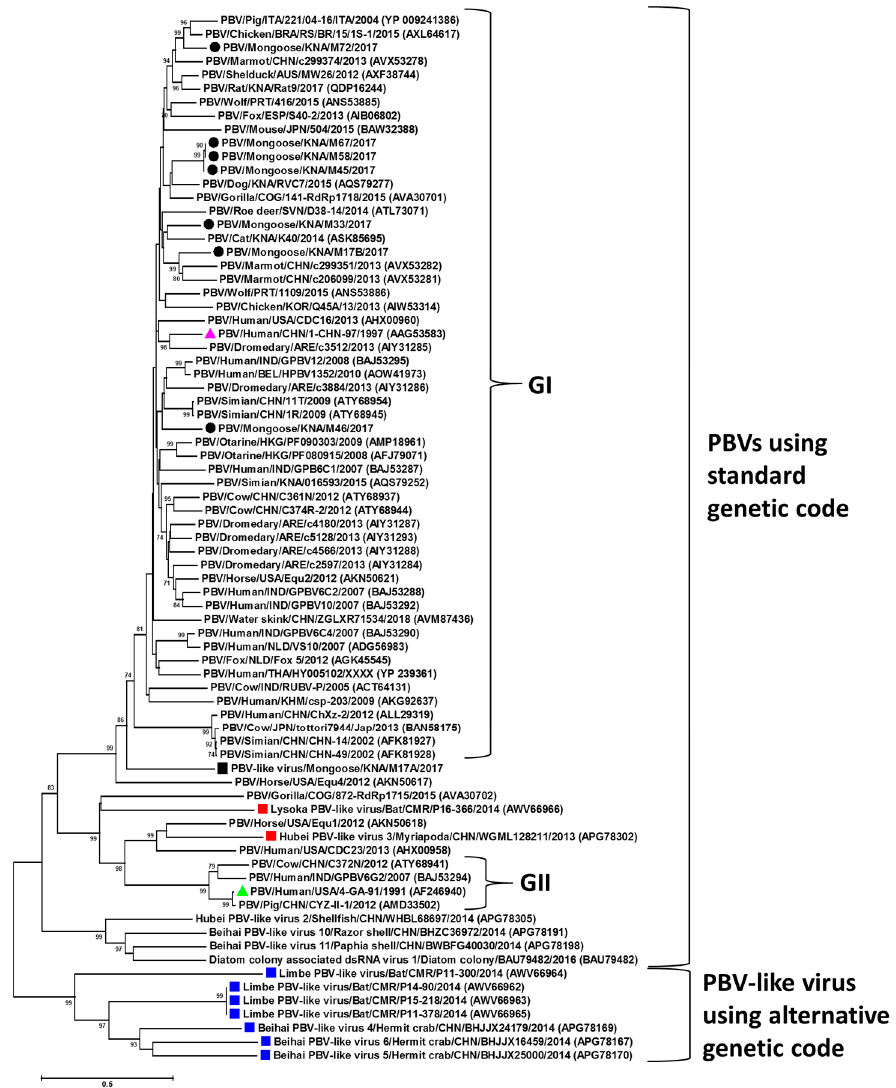
Figure 5. Phylogenetic analysis of the putative RNA-dependent RNA polymerases of the mongoose picobirnavirus (PBV) genogroup-I (GI) strains and the novel mongoose PBV-like virus with those of PBVs that use the standard genetic code and PBV-like viruses that use an alternative mitochondrial genetic code. GenBank accession numbers are shown in parentheses. Bootstrap values < 70% are not shown. Scale bar, 0.5 substitutions per amino acid. Black circles: mongoose PBV GI strains; Black square: the novel mongoose PBV-like virus that uses an alternative mold mitochondrial genetic code for translation; pink triangle: prototype PBV GI strain; green triangle: prototype PBV GII strain; blue squares: PBV-like viruses that use alternative genetic code and cluster separately from PBVs using the standard genetic code; red squares: PBV-like strains that use alternative genetic code, yet cluster within PBVs using standard genetic code.